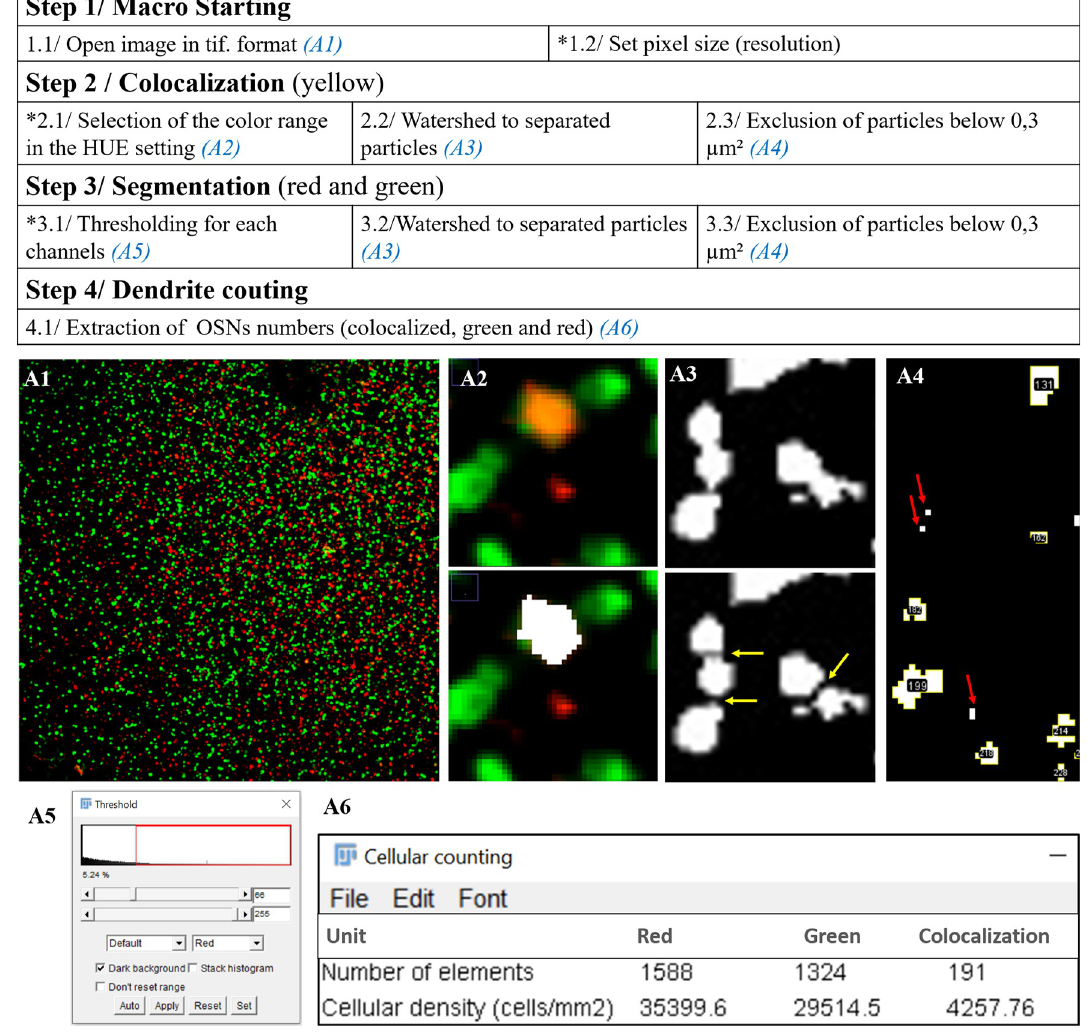
Fig 2. Workflow of the macro created for OSN counting. The different steps of the macro created from the Fiji/imageJ software are shown in the table above. The images (A1 to A6) below are there to help better understand the table. A3: Yellow arrows indicate particle separation. A4: Red arrows indicate the particles with a surface area < 0.3 μ m 2 that are excluded for counting. � The manual inputs include 3 steps: 1.2, 2.1 and 3.1. At completion, ‘OSNs counting’ generates a data table containing the number of green labelled OSNs, the number of red labelled OSNs and the number of colocalized OSNs (A6). OSN dendrite markers. For the application of immunostaining on flat-mounted mucosa, we looked here for olfactory markers located in the most superficial layer of the OE, i.e. the markers localized in the dendrites or "dendritic knob". Five proteins were identified: OMP, Tuj-1, DCX, N-cadherin and PGP9.5 ( Figs 3 and 4 ). Olfactory nerves (axons) and sensory nerves. Four OSN markers (OMP, Tuj-1, DCX and PGP9.5) were associated with a strong labelling of the olfactory nerve fascicles (OSN axons). The N-cadherin was also detected in the olfactory fascicles, but with a weak staining. We found that GAP43 and G β labeling was preferentially in the olfactory nerves located in the lamina propria. Their staining was very weak in cilia, dendrites and soma of OSNs ( S1A and S1C Fig ). The 3 neurofilaments (NF) subunits (NF-L, NF-M and NF-H) and peripherin were